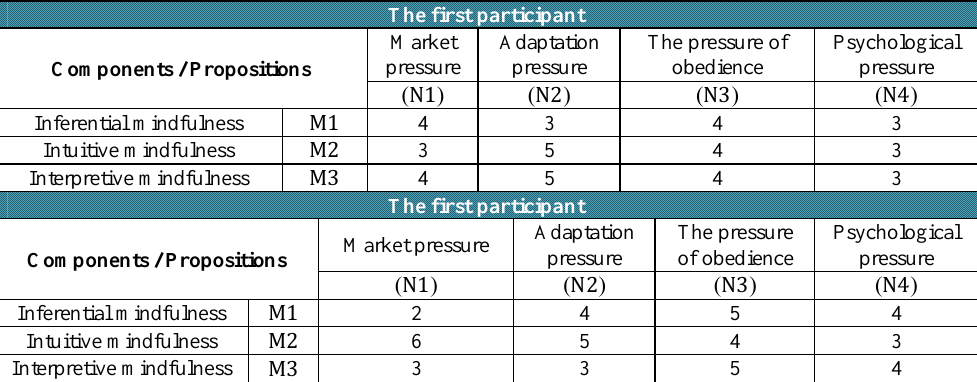
Table 9. Expert opinion on each of the options based on what